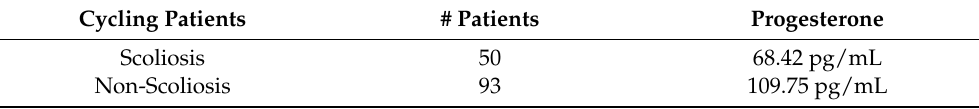
Table 1. Progesterone values for entire cohort. Group # Patients Progesterone # Cycling Scoliosis 68 67.79 pg/mL 50 Non-Scoliosis 173 101.63 pg/mL 93